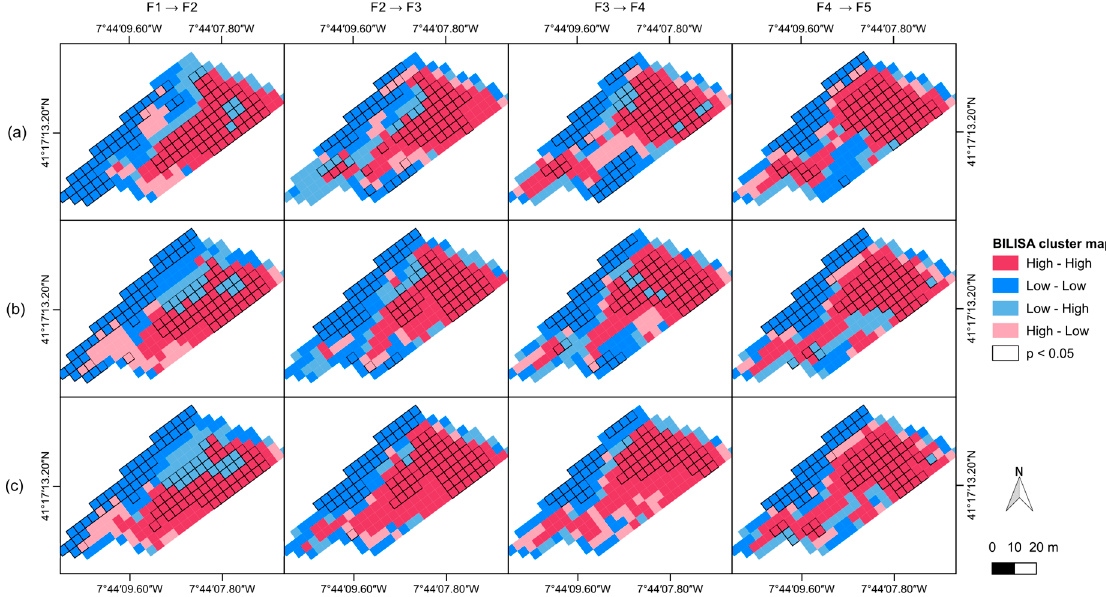
Figure 13. BILISA cluster maps between NDVI vigour maps of two consecutive flight campaigns for the three evaluated approaches: ( a ) first approach, ( b ) second approach, and ( c ) third approach. Associations with a p -value < 0.05 are highlighted with a black border.